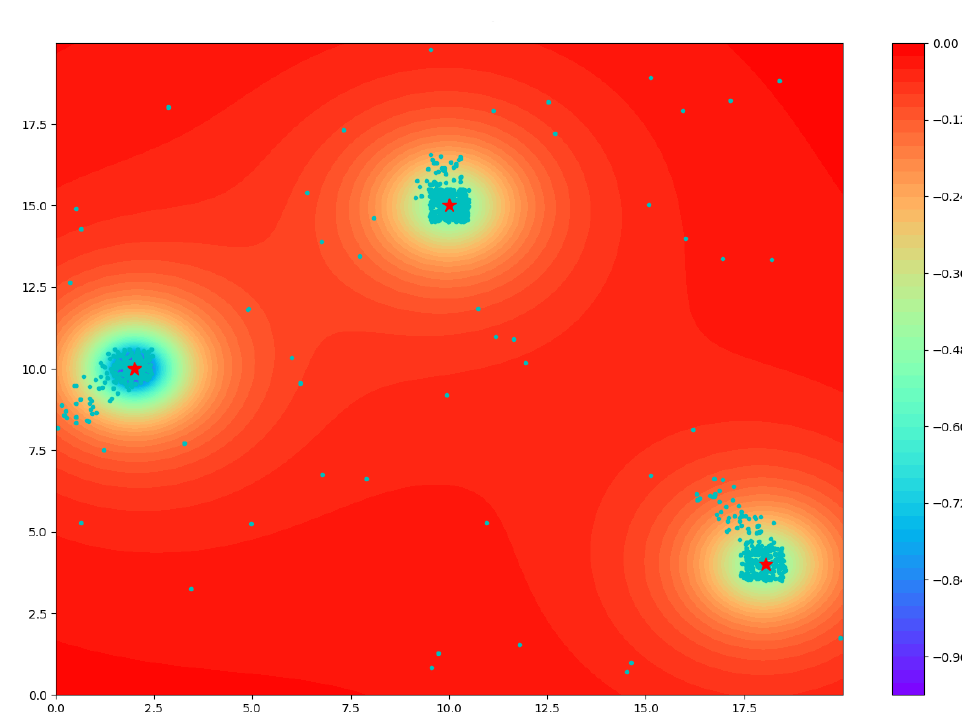
Figure 4. Rosenbrock function.